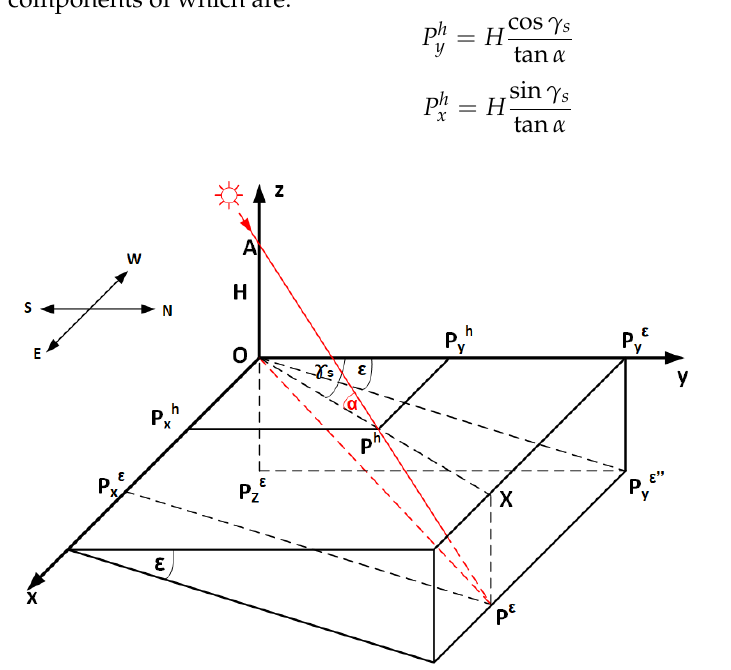
h P and on a north-